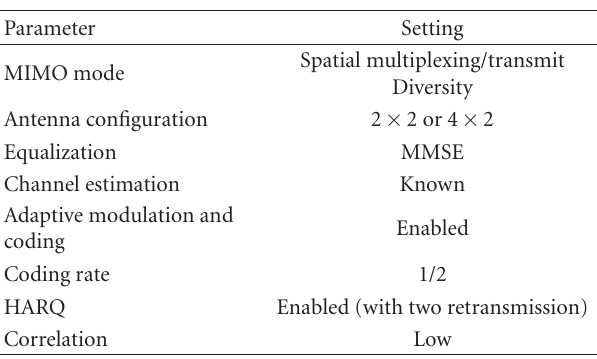
Table 6: LTE link simulation